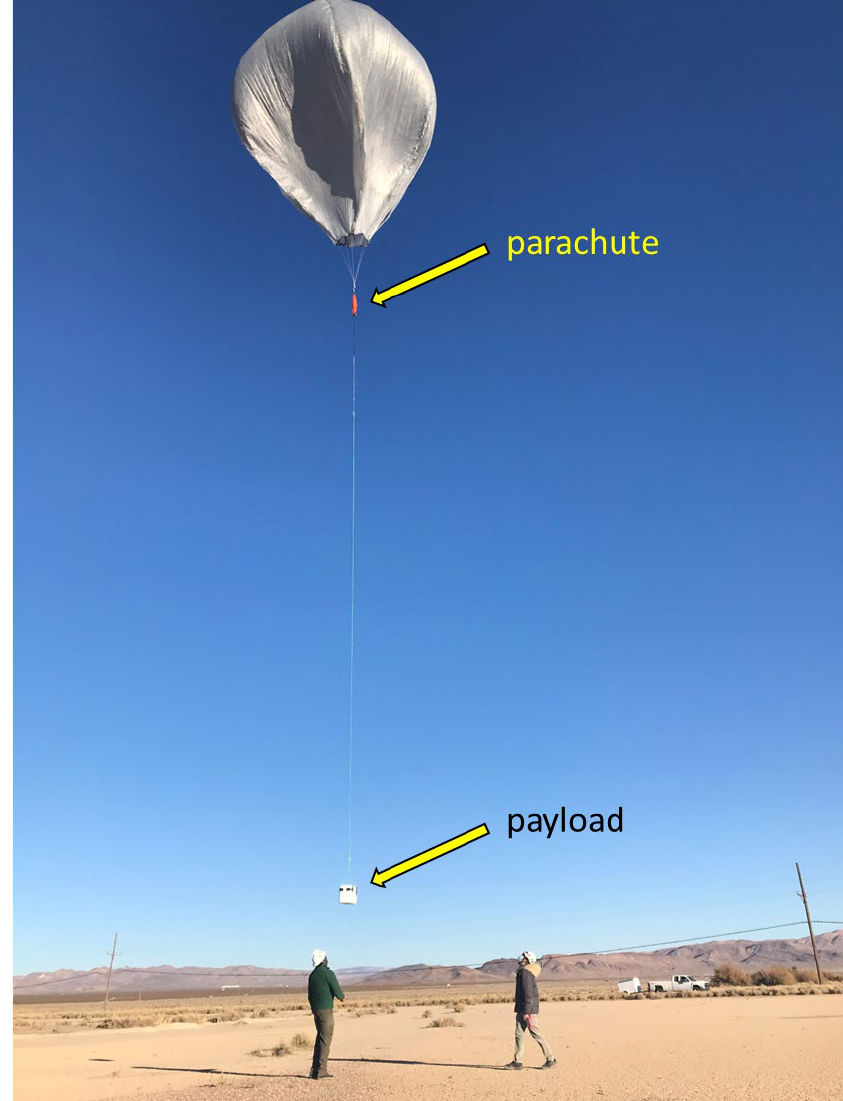
Figure 1. Solar hot air balloon launch. The payload and parachute are shown with the arrows. The balloon envelope size is 6 m.